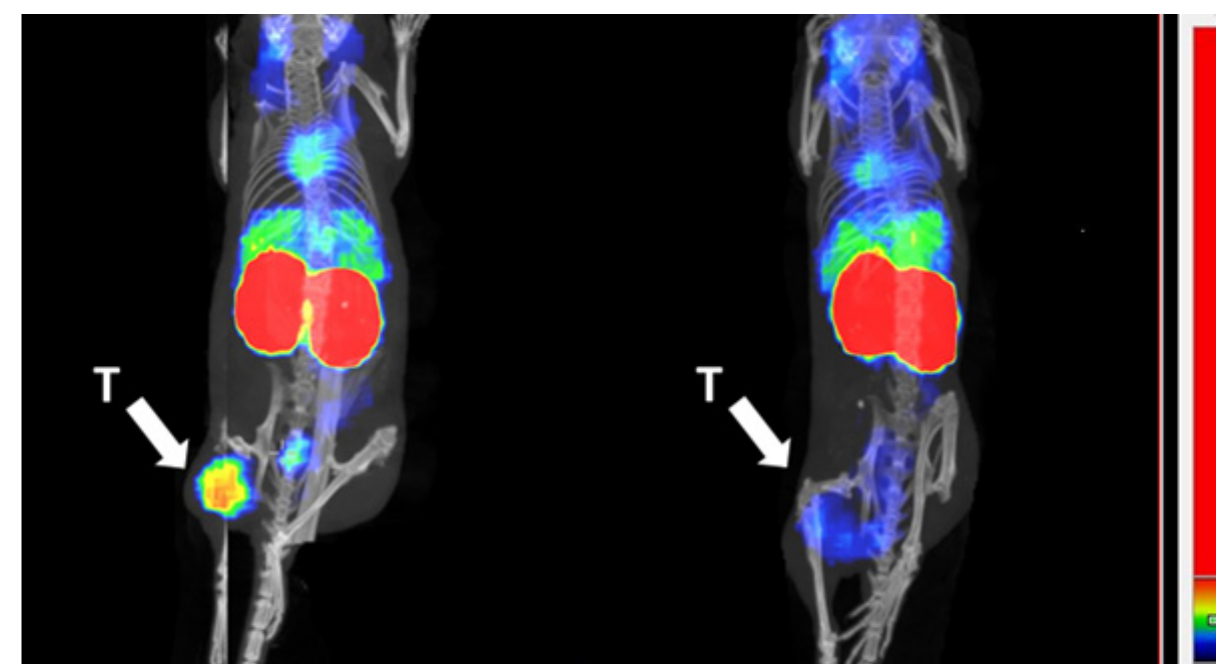
Figure 9. Imaging and tumor targeting specificity of 99m Tc-ADAPT6-ABD-mcDM1. SPECT/CT images (maximum intensity projections). The left image shows a mouse after injection of ADAPT6-ABD-mcDM1 and the right picture shows an animal where the tumor had been pre-saturated by injection of a large amount of trastuzumab. The arrow with the letter “T” points to the tumors, which were implanted in a hind leg. The color scale sidebar shows relative